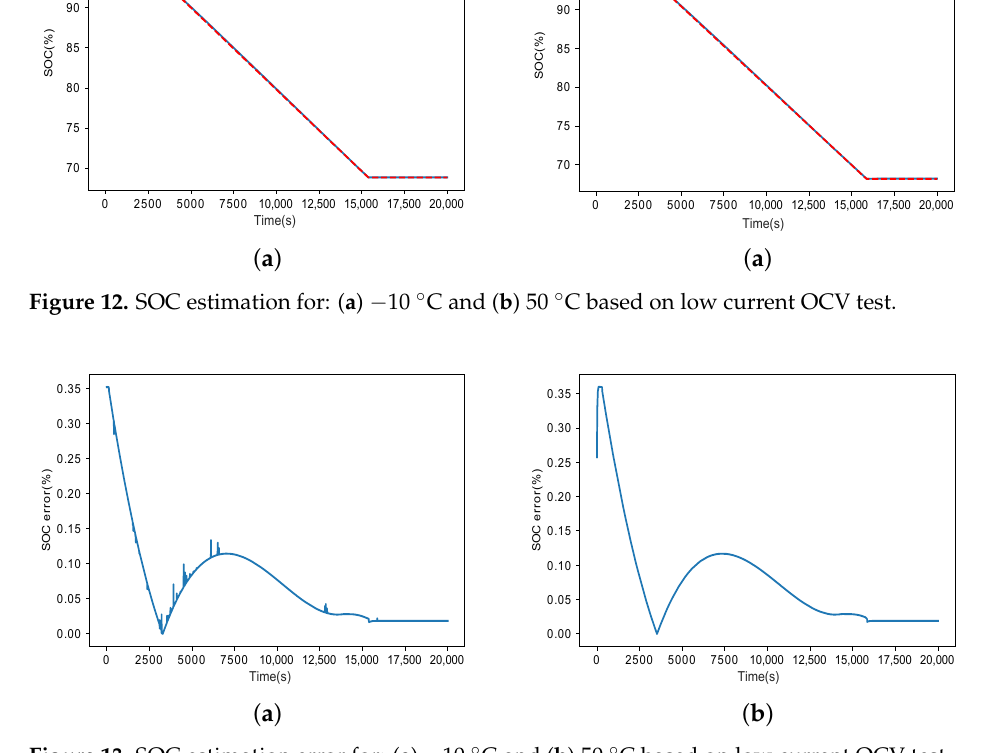
Figure 13. SOC estimation error for: ( a ) − 10 ◦ C and ( b ) 50 ◦ C based on low current OCV test.